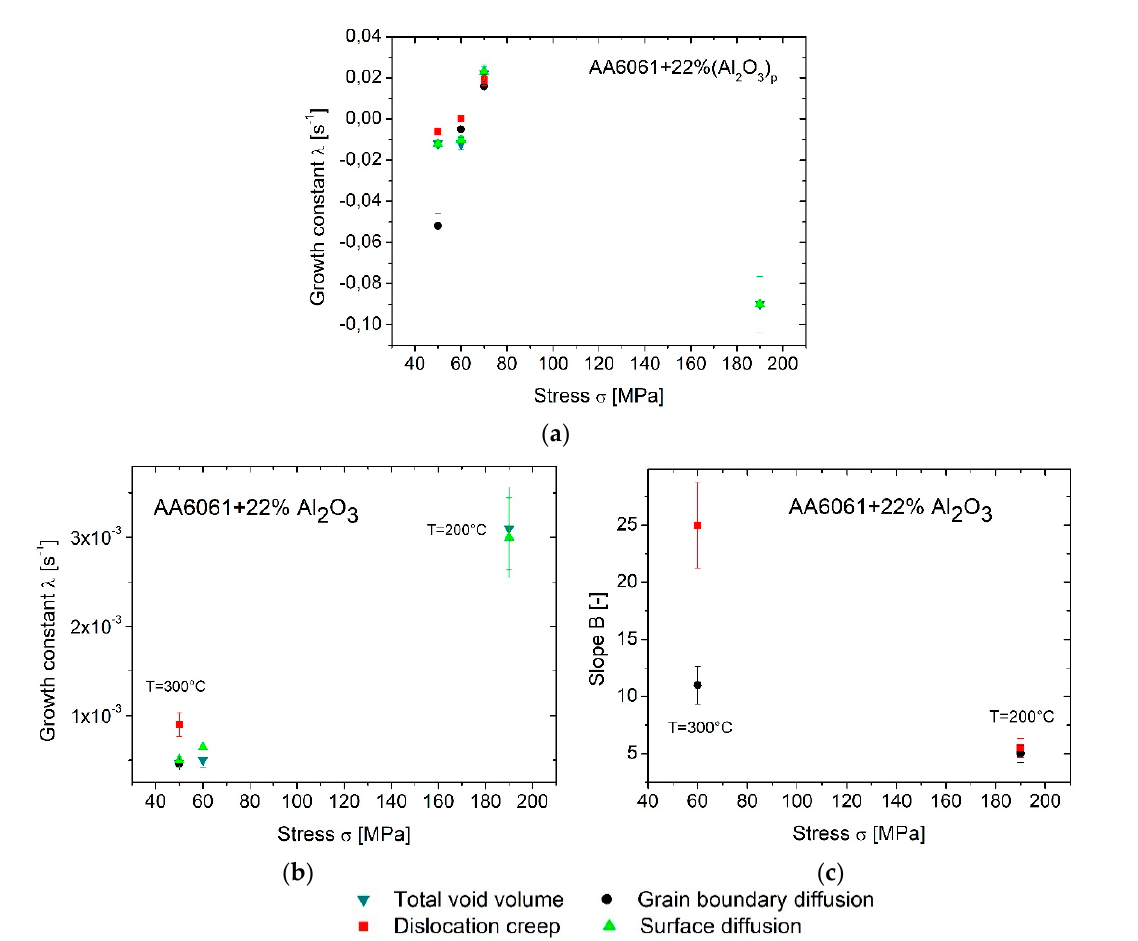
Figure 10. Al-MMC, void growth: ( a ) early stage, exponential fit; ( b ) late stage, exponential fit; ( c ) late stage, linear fit.